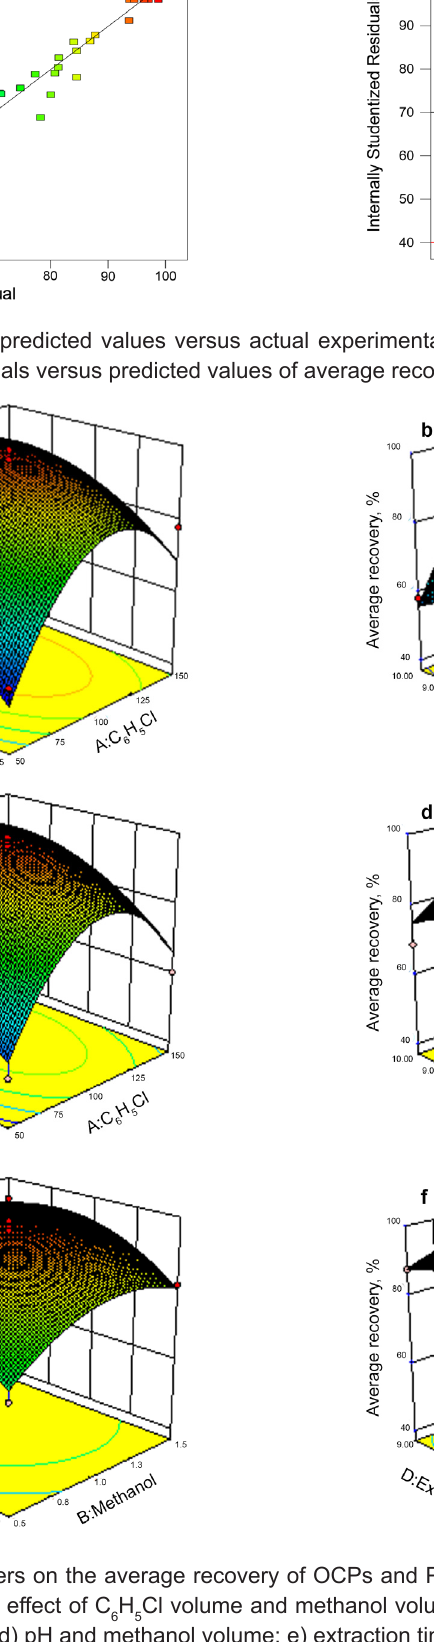
H Cl volume; c) extraction 6 5